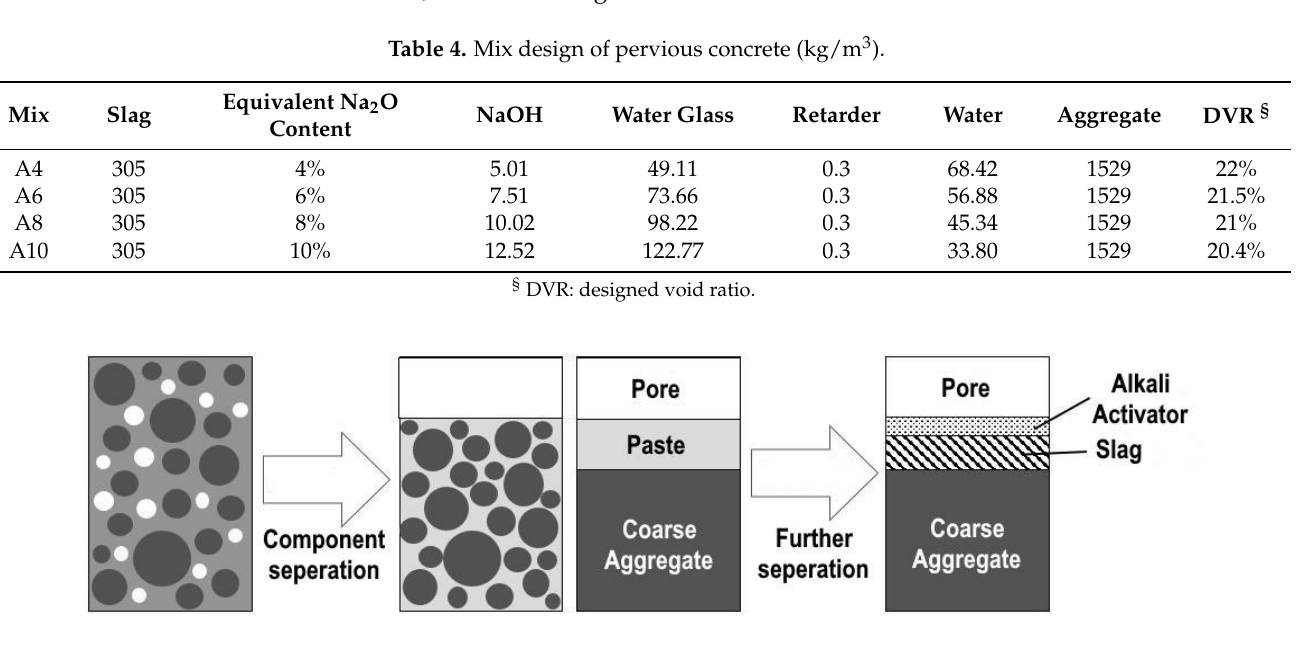
Table 3. Properties of coarse aggregate.